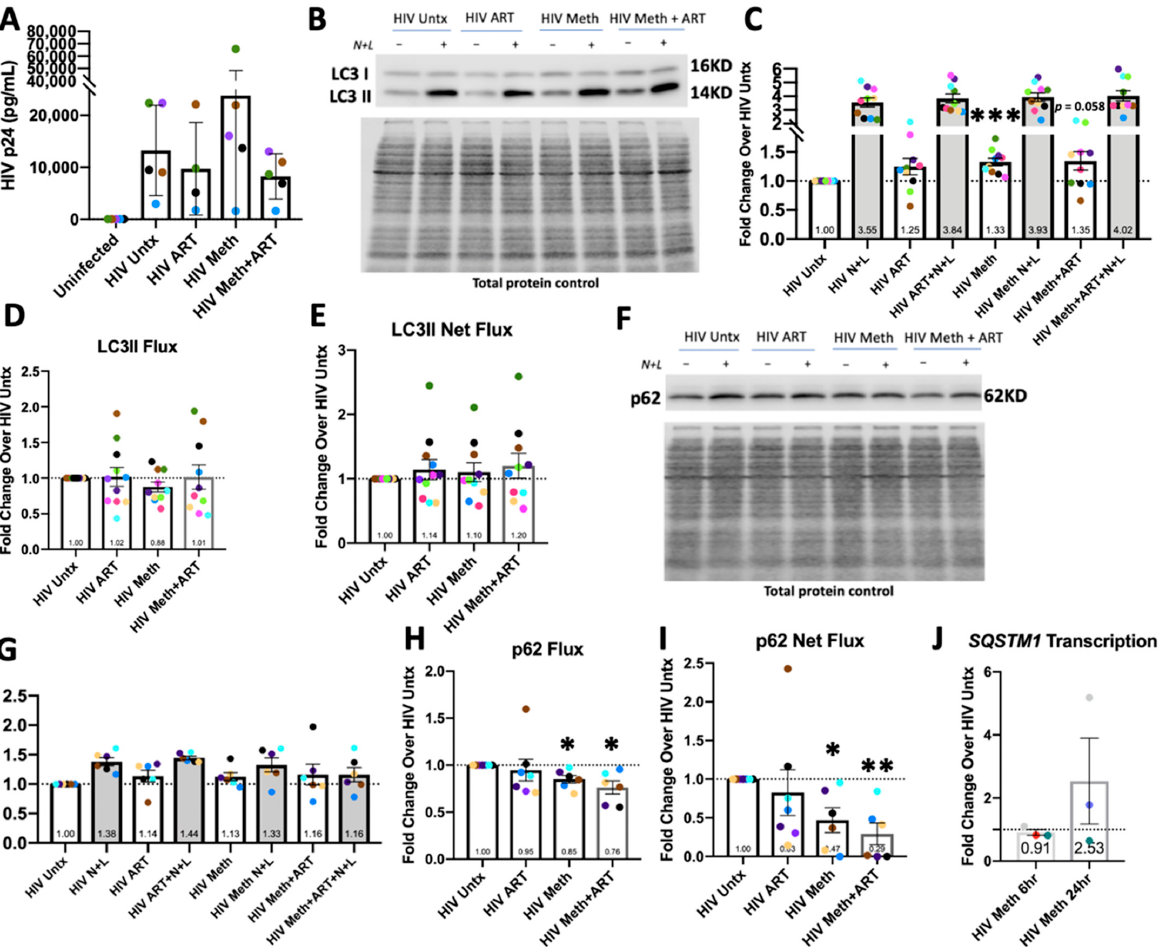
Figure 5. Normalized LC3II and p62 levels, LC3II or p62 flux, LC3II or p62 net flux, and SQSTM1 transcription in HIV-infected macrophages. PBMC were cultured into MDM, infected with HIV-ADA as described, and left untreated (HIV Untx) or treated with meth and/or ART for 24 h. NH4Cl and leupeptin (N + L) were added directly to indicated cultures in the last 4 h. ( A ) HIV p24 values in pg/mL from supernatants in five experiments, including the untreated control (HIV Untx). ( B ) Representative Western blot for LC3I and LC3II. ( C ) LC3II levels normalized to total protein content and then to HIV Untx control set to 1.0 in each experiment. ( D ) LC3II flux calculated using LC3II values with HIV Untx set to 1.0. ( E ) LC3II net flux calculated using LC3II values with HIV Untx set to 1.0. ( F ) Representative Western blot for p62. ( G ) p62 levels normalized to HIV Untx set to 1.0 in each experiment. ( H ) p62 flux calculated using p62 values with HIV Untx set to 1.0. ( I ) p62 net flux calculated using p62 values with HIV Untx set to 1.0. ( J ) RT-qPCR for SQSTM1 in HIV-infected MDM untreated or treated with meth for 6 h or 24 h. n = 3–10; * p < 0.05 ** p < 0.01 *** p < 0.001, one-sample t test. Error bars for ( A ) represent SD, all others represent SEM.